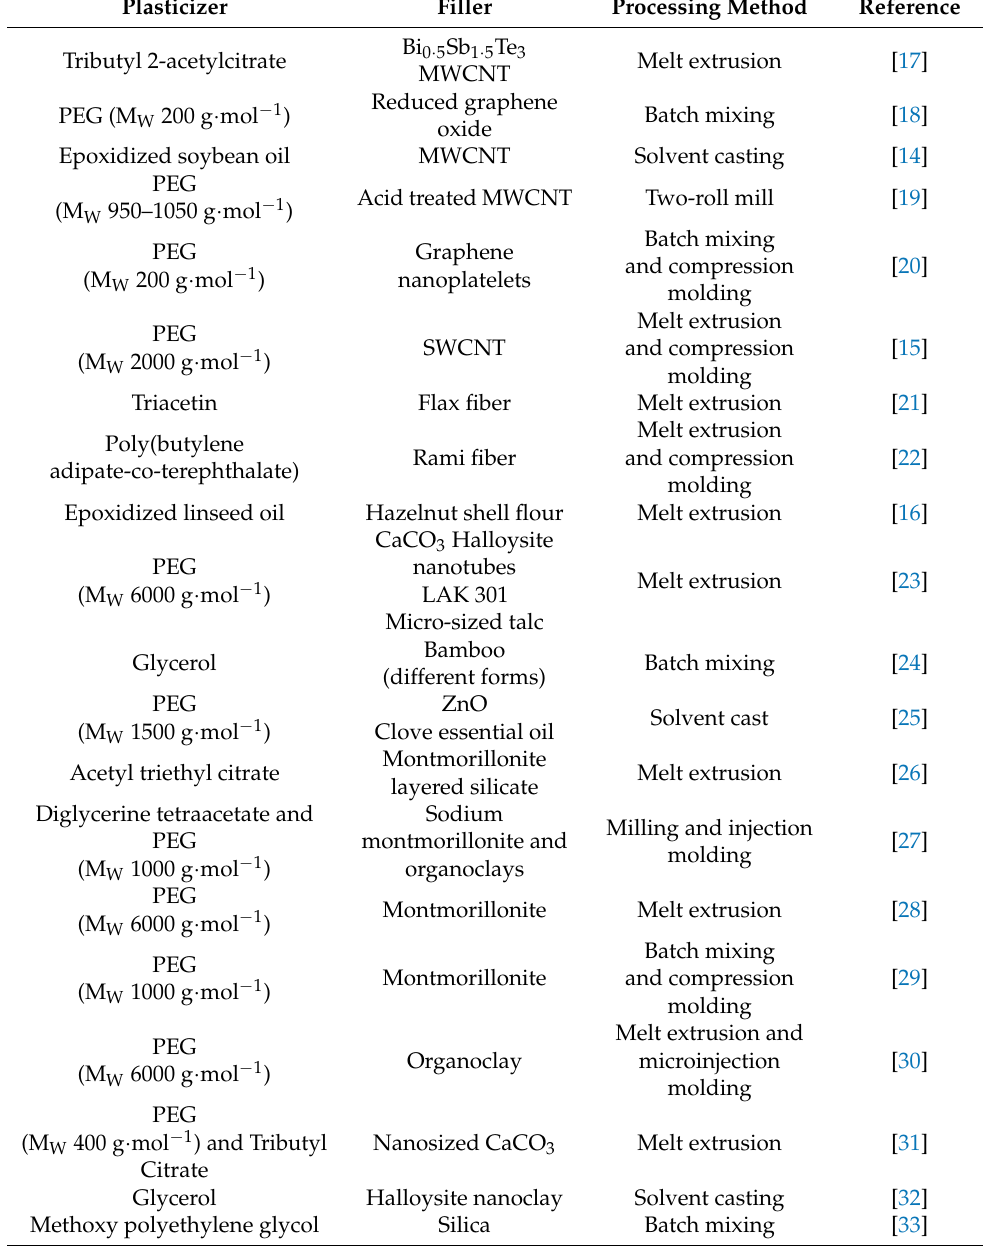
Table 1. Polylactic acid (PLA) composite systems with different plasticizers and